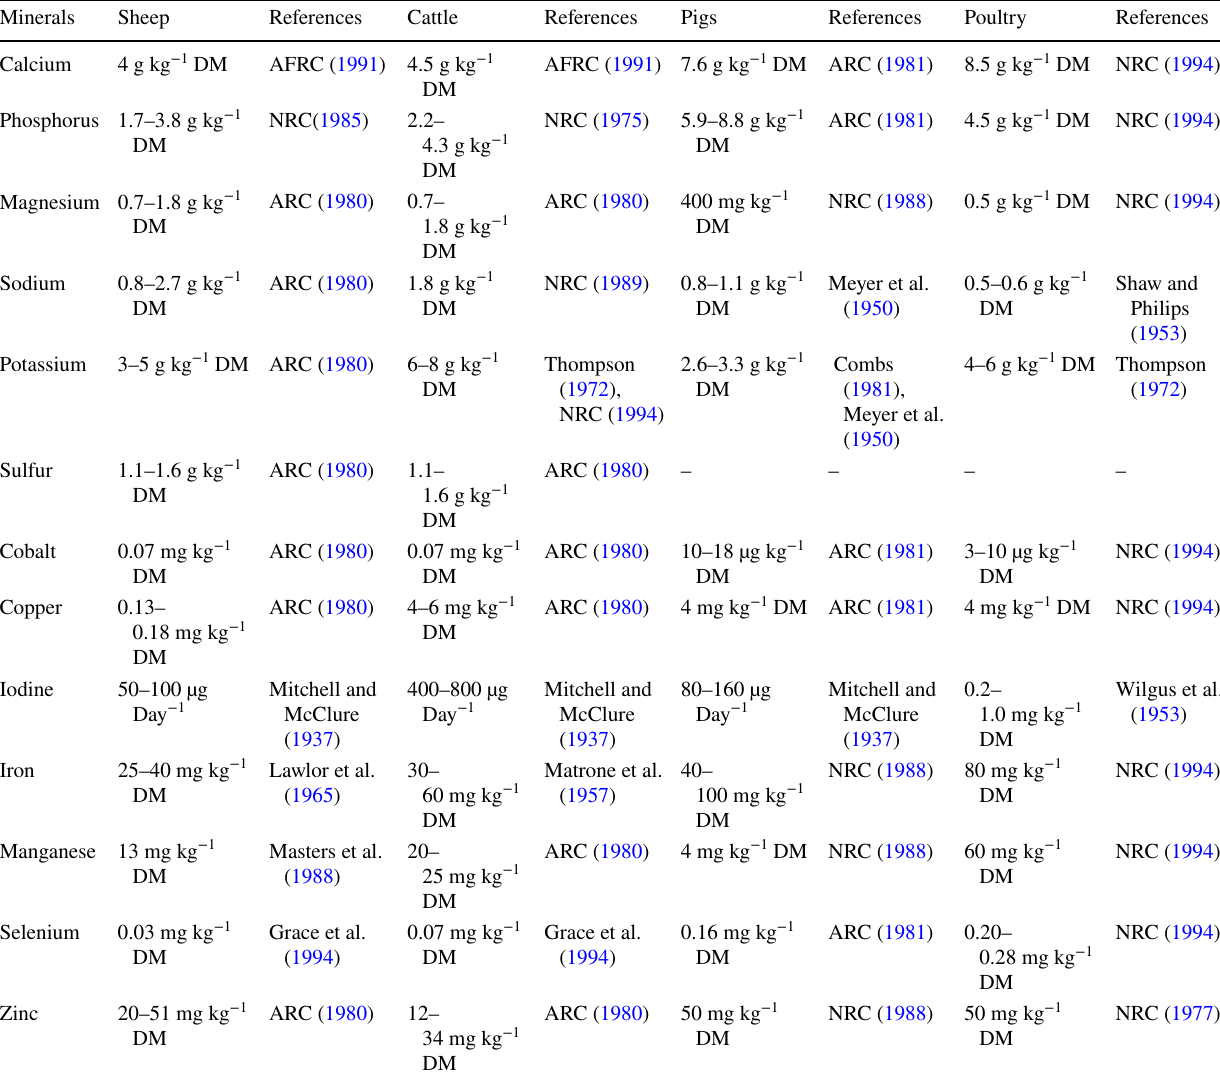
Table 6 Primary requirements of essential minerals in ruminants and non-ruminants (adopted from Underwood and Suttle 2001) Minerals